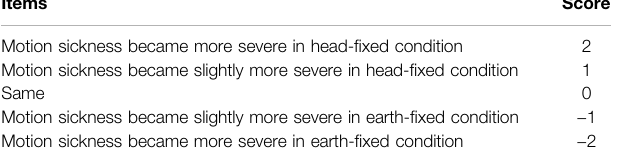
TABLE 2 | Relative evaluation questionnaire.